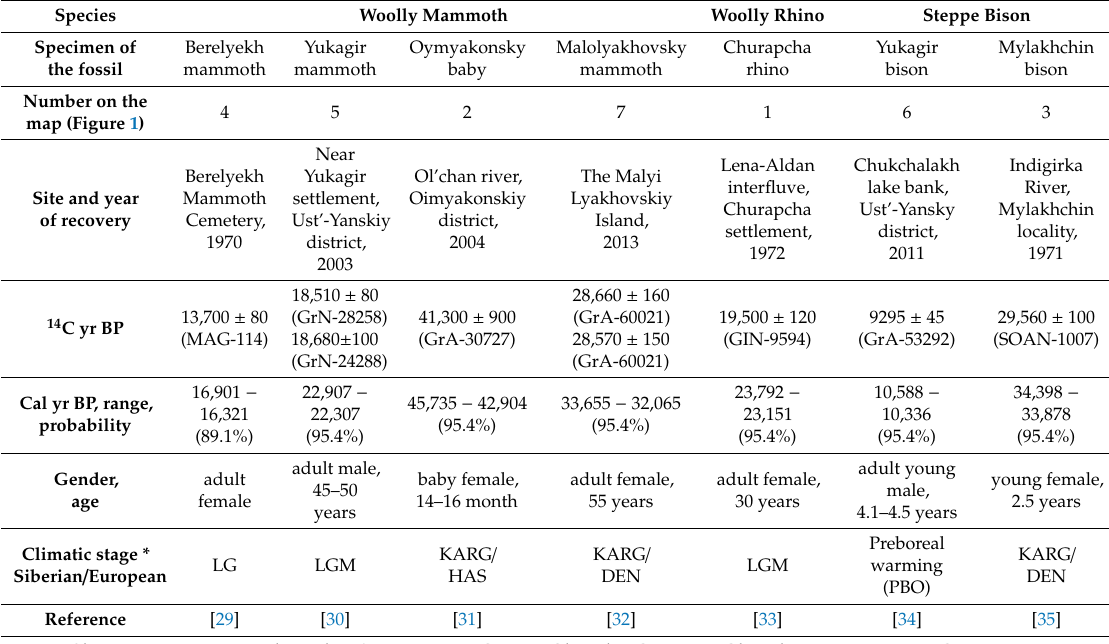
Table 1. Description of the studied Ice Age